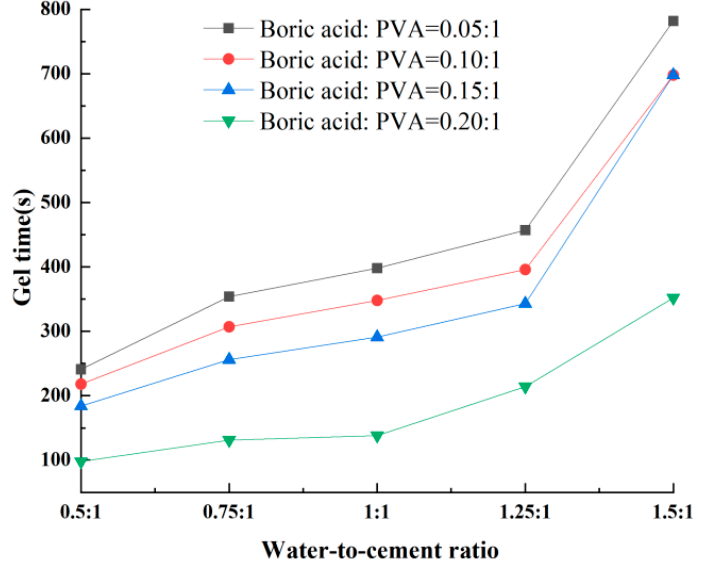
Figure 6. The influence of the water–cement ratio and boric acid on the slurry setting time.